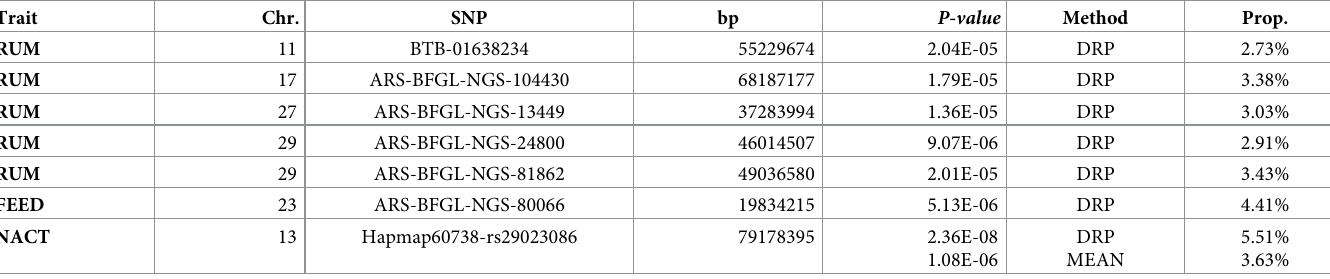
Table 2. List of SNP markers significantly associated with sensor behavior traits (significance threshold: False discovery rate of 20%). Trait Chr.